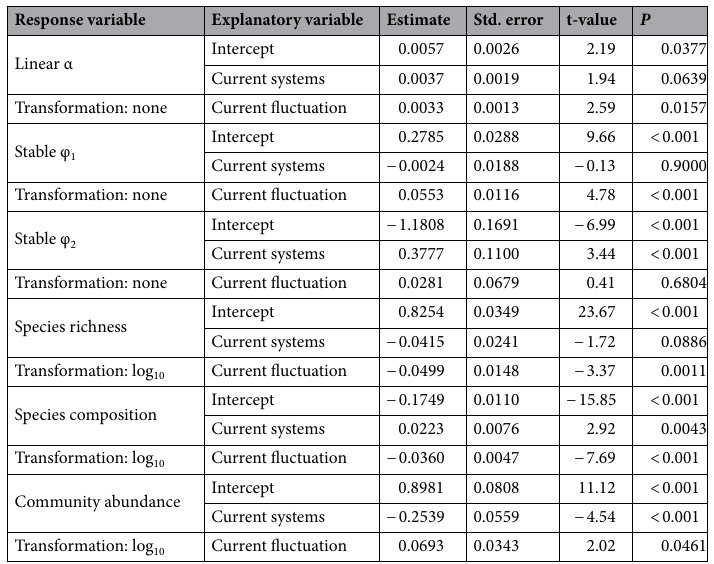
1 , 2 ]) and on three measures ϕ ϕ